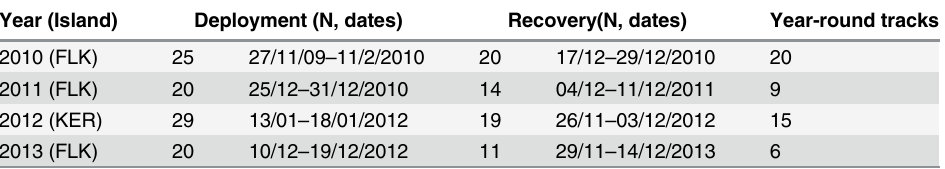
Table 1. Geolocator deployment and recovery times and sample sizes for thin-billed prions from the Falkland Islands (FLK) in 3 years and Kerguelen (KER) in